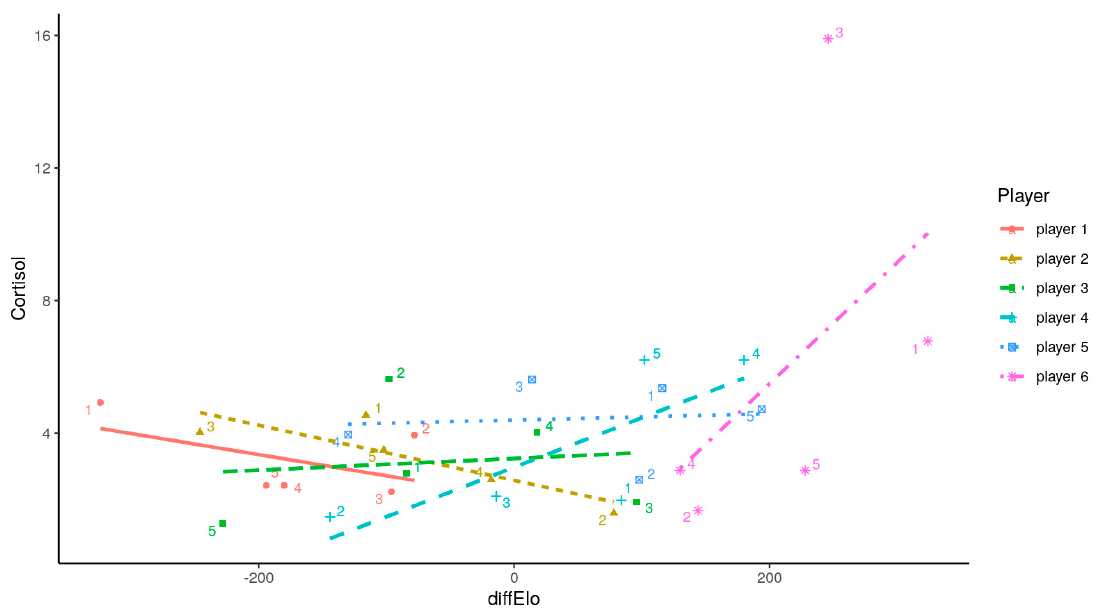
Figure 2. Individual salivary cortisol (ng/mL) production related to opponent´s ELO difference and number of each round. difELO = ELO difference between opponents; J1 = player 1; J2 = player 2; J3 = player 3; J4 = player 4; J5 = player 5; J6 = player 6.